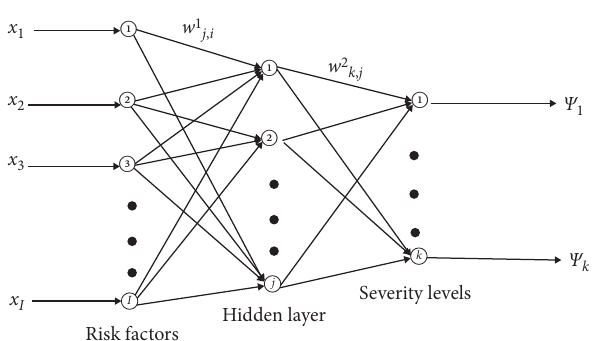
Figure 3: General structure of a typical NN used in this